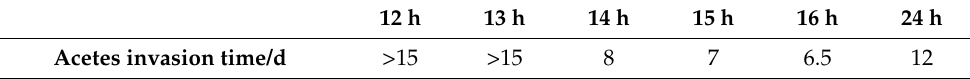
Table 5. Invasion times of Acetes for cases with various night-migration